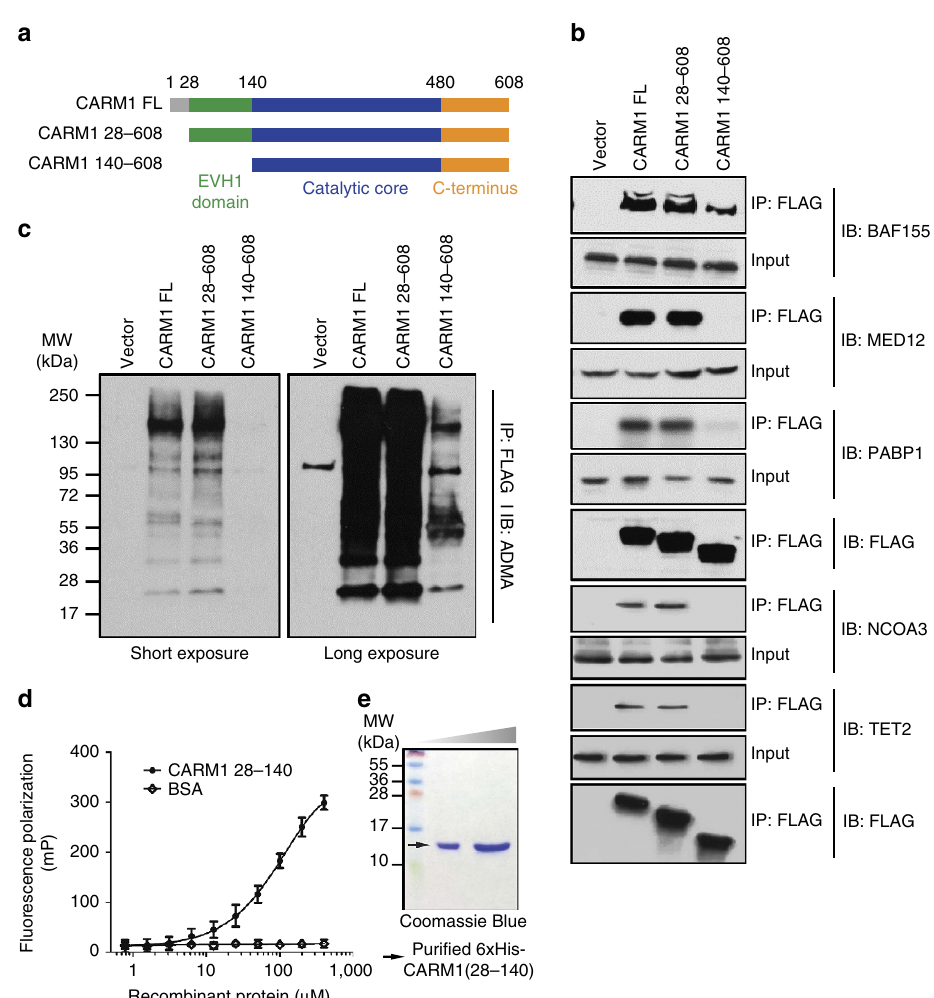
Figure 3 | Requirement of the N-terminal domain for substrate recognition by CARM1. ( a ) Schematic diagram of FL and N-terminal truncated CARM1 derivatives. CARM1 FL protein contained 608 residues. CARM1 28–608 lacks the first, unstructured 28 residues denoted in grey. CARM1 140–608 lacks the first 140 residues encompassing the EVH1 domain denoted in green. ( b ) Western blot analyses of co-immunoprecipitated BAF155, MED12, PABP1, NCOA3 and TET2 with FLAG-tagged CARM1, transiently transfected into HEK293T CARM1 KO cells. CARM1 was immunoprecipiated with the anti-FLAG antibody, and the presence of BAF155, MED12, PABP1, NCOA3 and TET2 in the immunoprecipitates was detected with western blots using the respective antibodies. The loading controls are depicted below the corresponding western blot results, separately for BAF155, MED12 and PABP1, and the other two proteins. In all cases the amount of co-precipitated protein was strongly reduced in cell lines expressing N-terminus truncated CARM1 140–608. ( c ) Western blot analyses of total ADMA-containing proteins co-precipitated with CARM1. The FLAG-tagged CARM1 immunoprecipitates in b were probed with ADMA antibodies. The strong reduction in the levels of ADMA—containing proteins in cells expressing CARM1 140–680 was evident on both short (left) and long exposure (right). The corresponding loading control was shared between the experiments in b (BAF155, MED12 and PABP1) and c and is depicted in b labelled with IB: FLAG. ( d ) FP assay using purified recombinant 6xHis-CARM1 28–140 and fluorescein-labelled BAF155 peptide. Pronounced increase in FP was observed at high concentrations of recombinant CARM1, but not with the BSA control, demonstrating that the EVH1 domain of CARM1 directly interacts with the enzyme’s substrate at low affinity. ( e ) Coomassie Blue staining of highly purified recombinant 6xHis-CARM1 28–140 used in the FP assay ( d